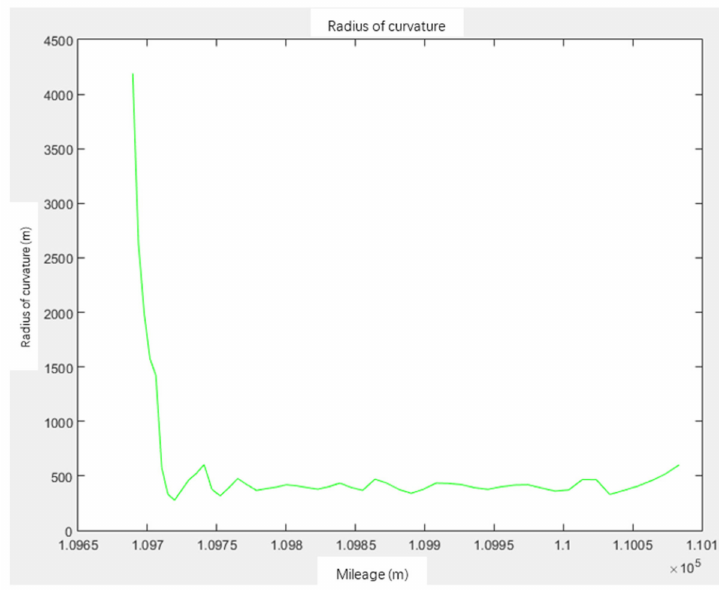
Figure 6. Radius of